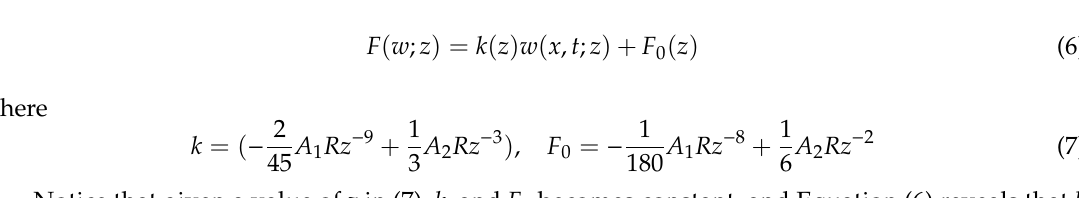
Figure 1. The displacements of the tip in static equilibrium state and vibration state.